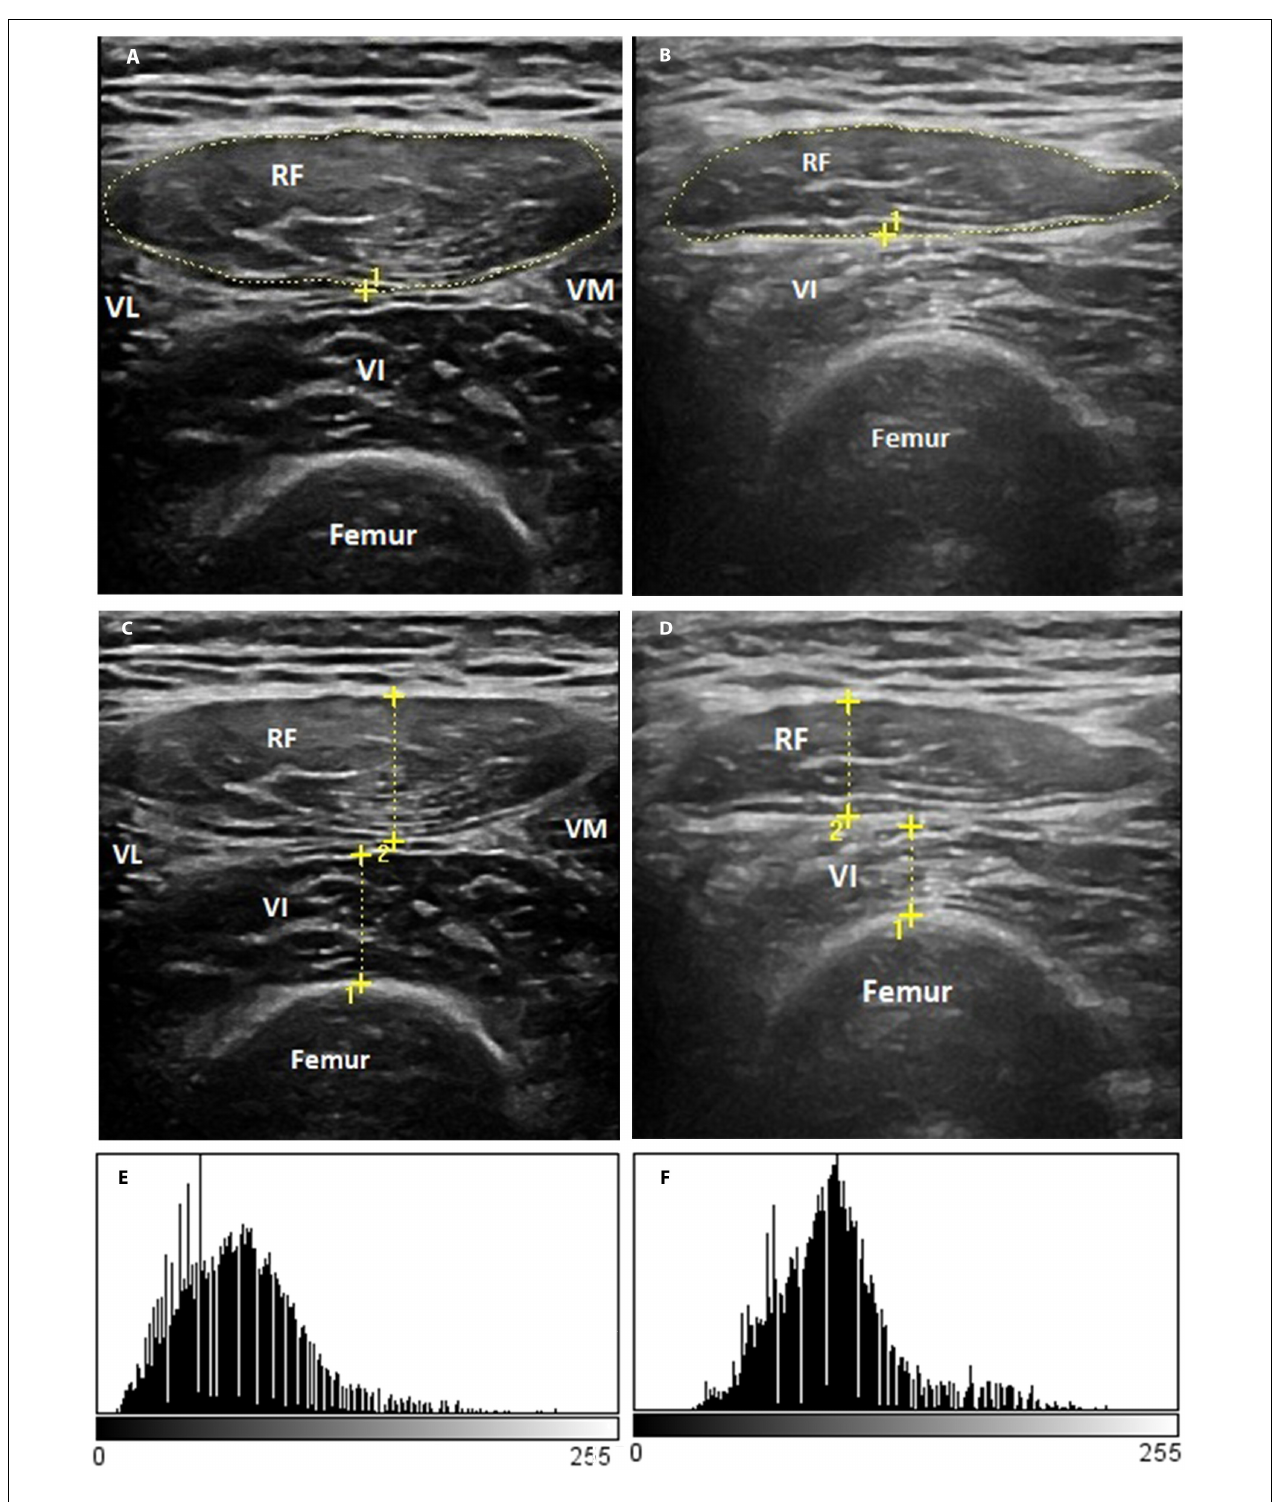
FIGURE 3 | Representative qualitative muscle ultrasound image: rectus femoris cross-section area (A,B) , the thickness of the anterior compartment of the quadriceps muscle (rectus femoris and vastus intermedius) (C,D) , and rectus femoris echogenicity (E,F) . The representative image is of a male patient, a 55-year-old man with a positive diagnosis for SARS-CoV-2 infection and that showed a severe illness.